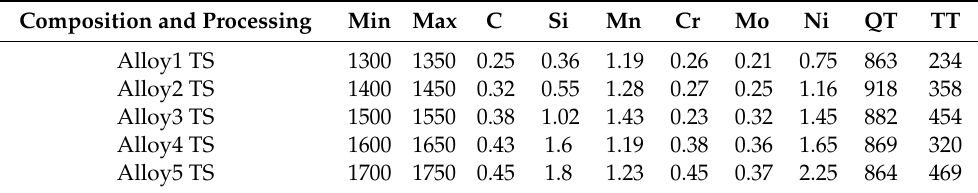
Table 6. Characteristic elements corresponding to the tensile strength output